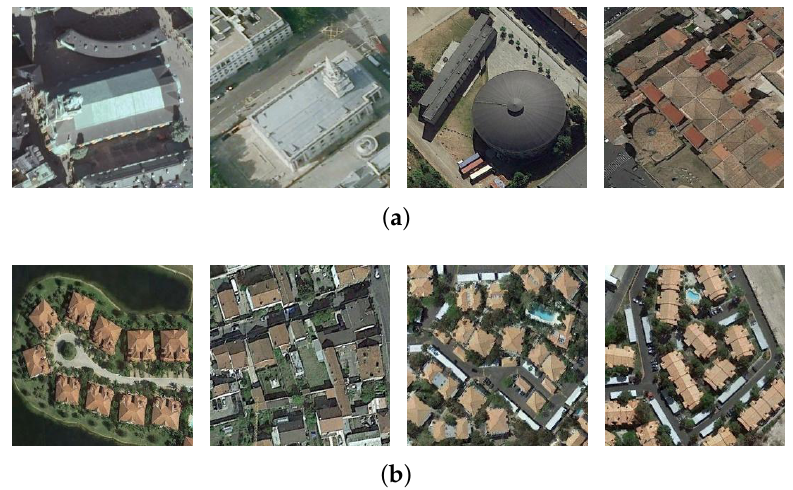
Figure 2. Illustration of the high inter-class similarity and high intra-class variance in the remote sensing image dataset. ( a ) Illustrates four images with different appearances, which are labelled as church. ( b ) Shows dense residential in the left two images, and medium residential in the right two